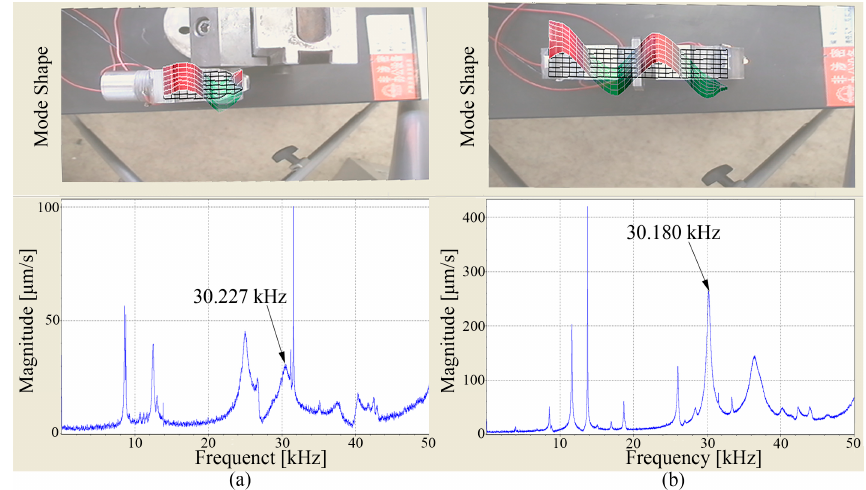
Figure 6. The results of vibration scanning: ( a ) The coupling bending vibrations of the vertical transducers; ( b ) The coupling bending vibration of the horizontal transducer.